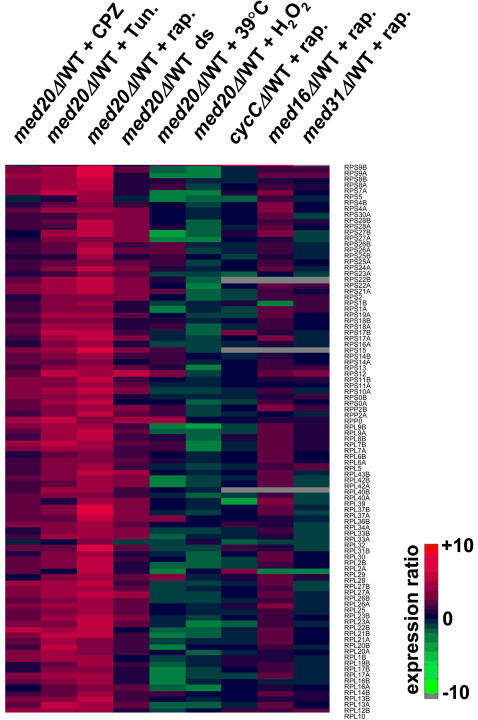
Analysis of RP gene expression in Mediator subunit deletion strains under different repressing conditions.Clustergram comparison of expression ratios are shown for 96 RP genes. Changes in expression (increased in red and decreased in green) are shown relative to the treated wild-type strain under six repressing conditions (rapamycin, tunicamycin, CPZ, post-diauxic shift, transient heat shock and hydrogen peroxide, see Methods). The effect of rapamycin is compared in four Mediator subunit deletion strains. Each deleted subunit represents a different structural module of the complex (med20 in the head, med31 in the middle, med16 in the tail and cycC in the Cdk module). Except for the transient heat shock, all strains were grown at 30°C.